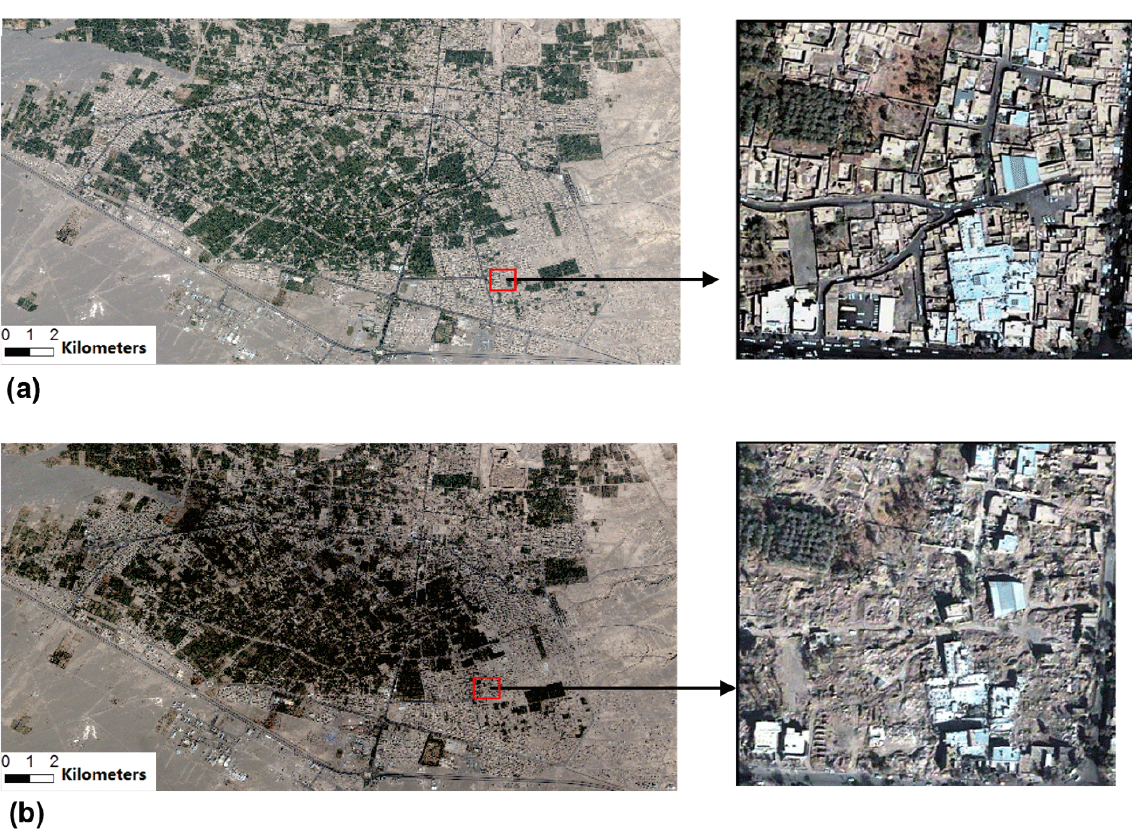
Figure 3. Pre- and post-seismic QuickBird images of the Bam